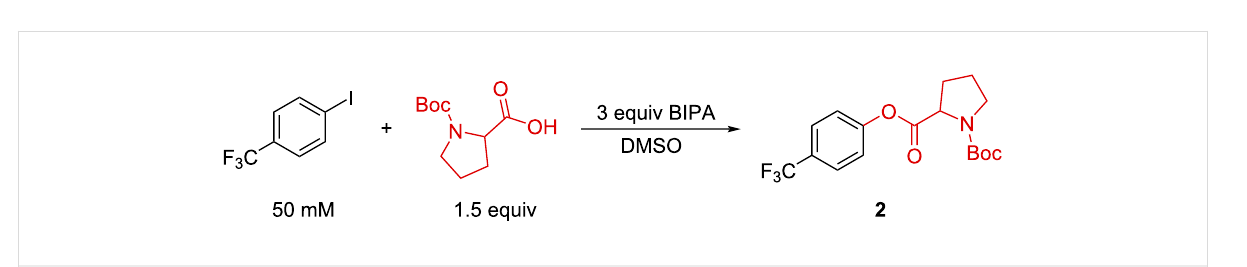
Scheme 1: C–O coupling between 4-iodobenzotrifluoride and N